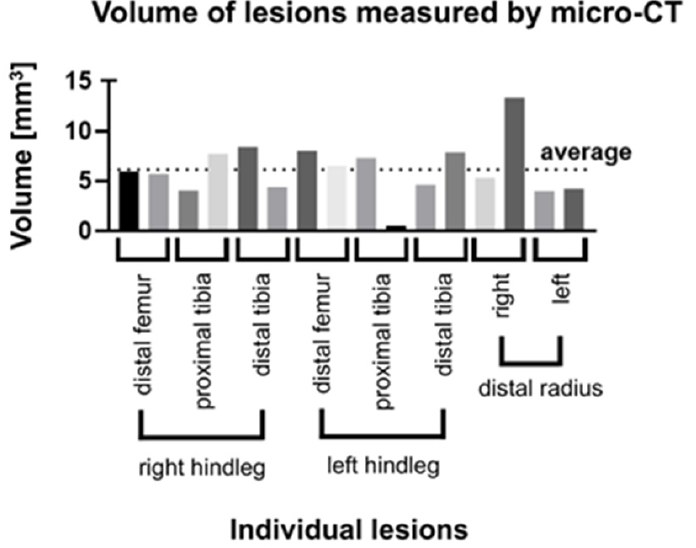
Figure 4. Volume of lesions measured using micro-CT. The volume of lesions are shown [mm 3 ] on the y -axis and the lesion locations on the different extremities are shown on the x -axis. The black dashed line indicates the average.